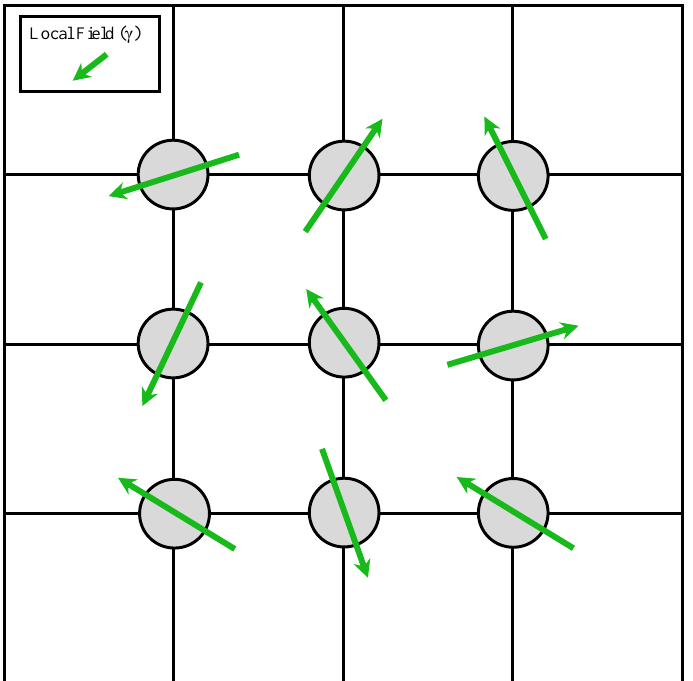
Figure 3. (Color online) Vertex model of local fields. A spin rotates a set amount γ about a random direction (green arrows) when hopping to a site. Each site has a fixed γ